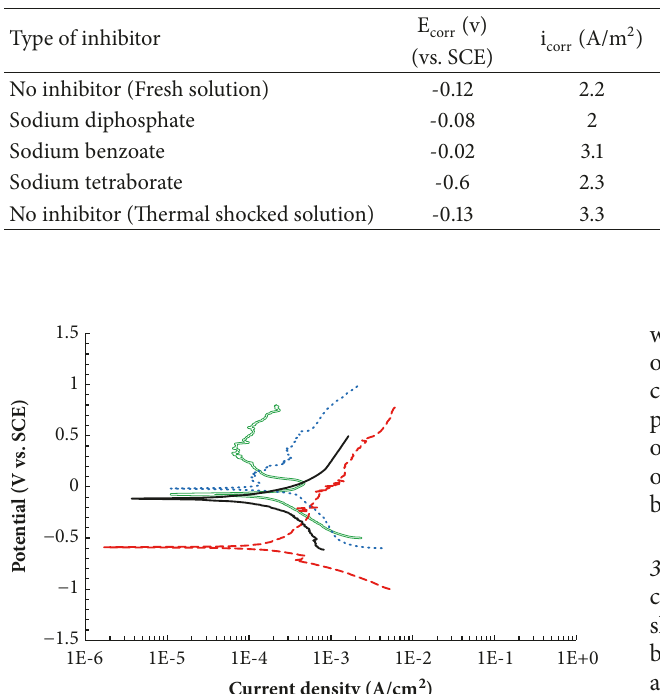
Table 1: Electrochemical parameters of the potentiodynamic polarization tests for the studied solutions.